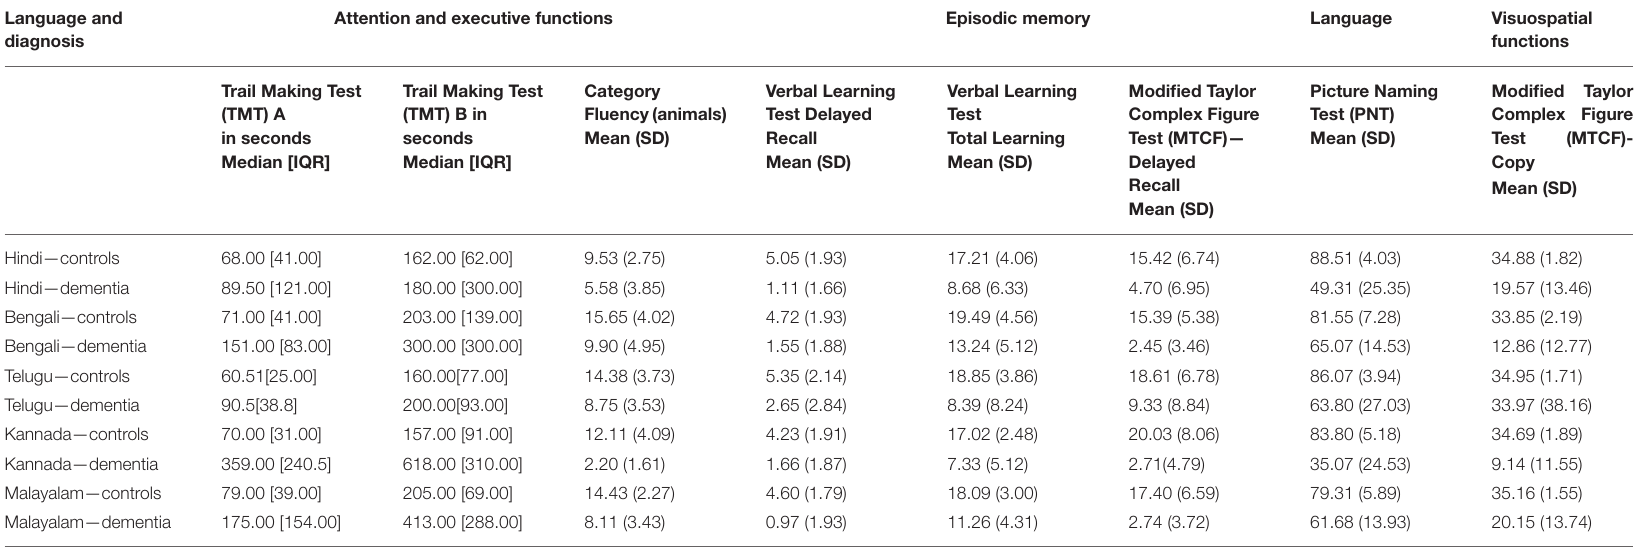
TABLE 2 | ICMR-NCTB test scores of healthy controls and patients with dementia in Hindi, Bengali, Telugu, Kannada, and Malayalam. Language and